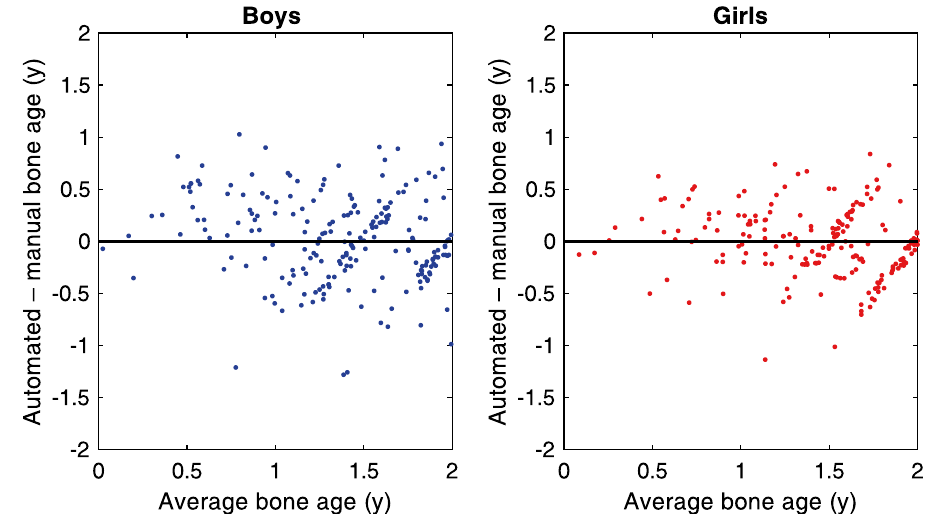
Figure 5. Bland Altman plot of the agreement between automated and manual bone age rating below 2